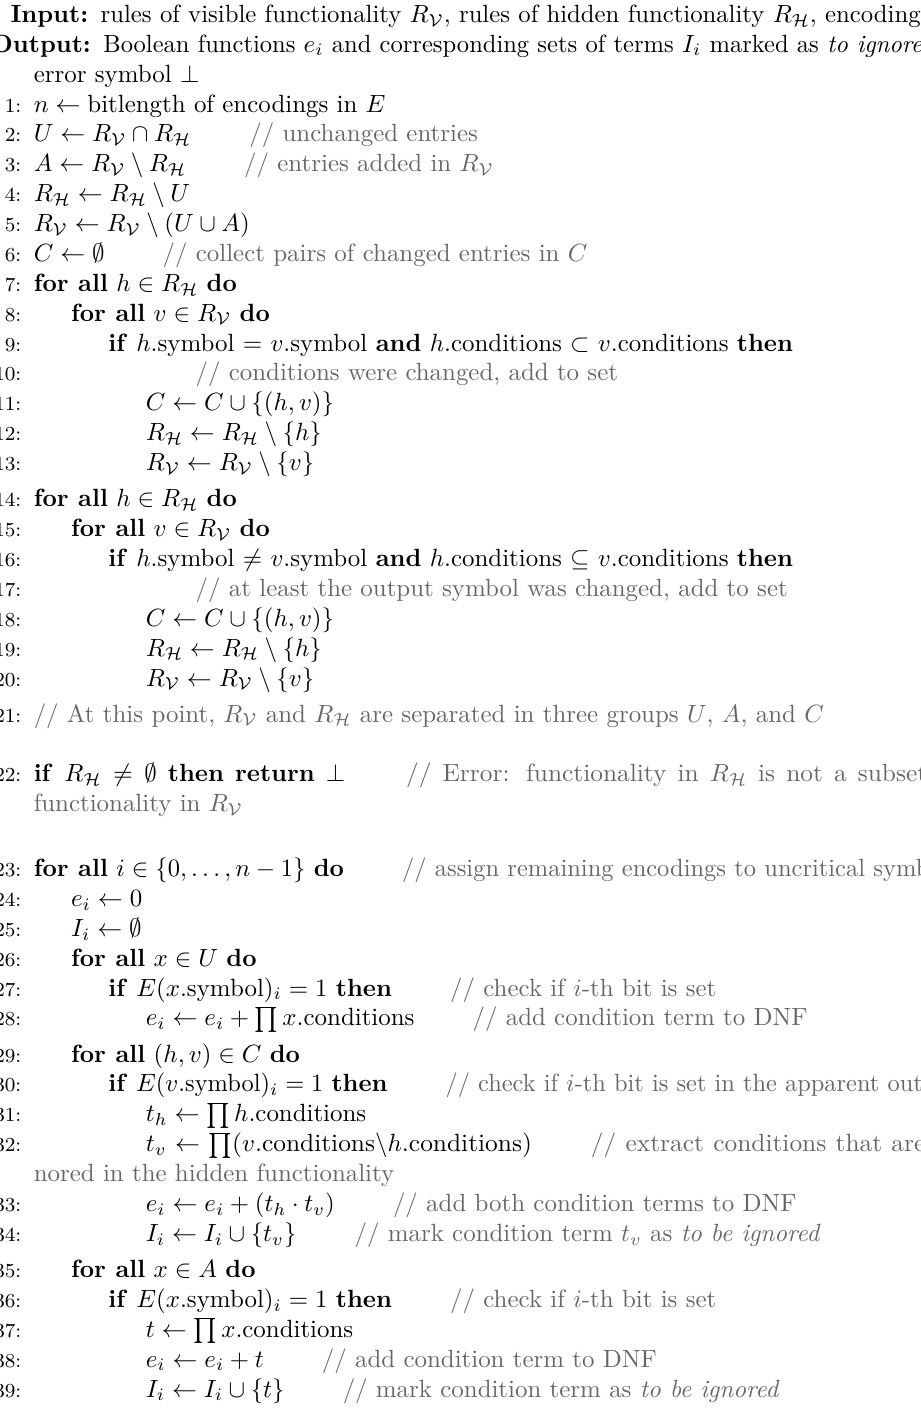
Algorithm 3 Output Logic